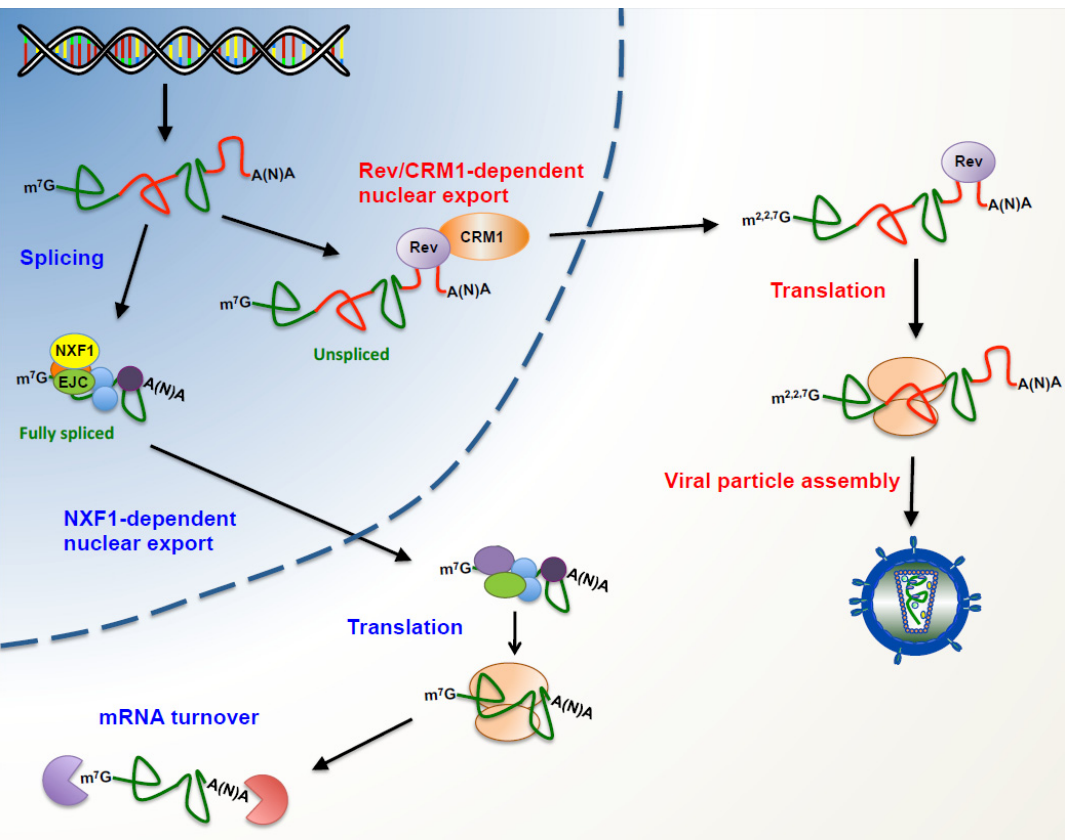
Figure 1. Post-transcriptional control on human immunodeficiency virus (HIV). Upon transcription, the capped and polyadenylated full-length genomic RNA is used as a template for the host mRNA processing machinery in order to generate fully spliced and partially spliced transcripts (partially spliced transcripts have been omitted for simplicity). In the nucleus, fully spliced transcripts form a classical messenger ribonucleoprotein complex (mRNP) together with host proteins such as the exon junction complex (EJC) and the mRNA export factor NXF1. In the cytoplasm, fully spliced mRNAs recruit the host translational apparatus for protein synthesis and later they are degraded by the mRNA turnover machinery. In the presence of the viral protein Rev, the unspliced genomic RNA (and partially spliced mRNAs) reaches the cytoplasm through the CRM1-dependent pathway avoiding the host cell surveillance mechanisms. During this journey to the cytoplasm, the unspliced genomic RNA forms a unique mRNP that favors its association with the host translational machinery. In contrast to the fully spliced transcripts, the unspliced genomic RNA does not undergo turnover as it is incorporated into viral particles.